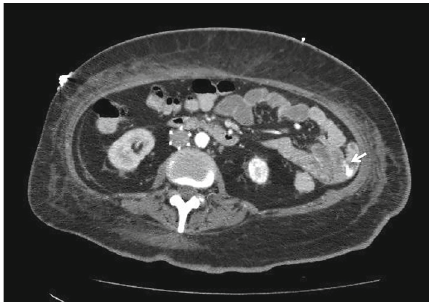
Figure 3: Histopathological examination of the intestine showed granulomatous vasculitis of submucosal vessels.